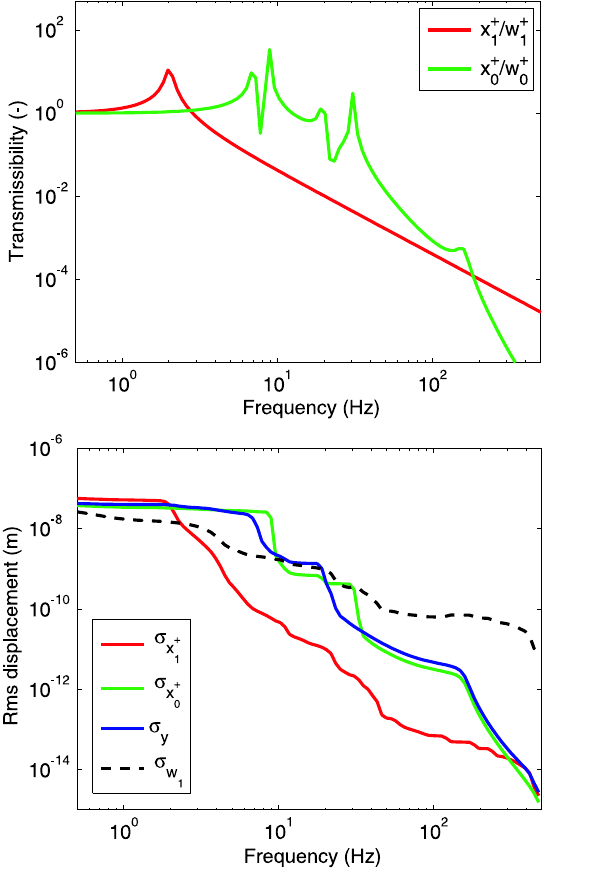
.FIG. 12. Transfer functions and integrated rms values of the quadrupoles response for f